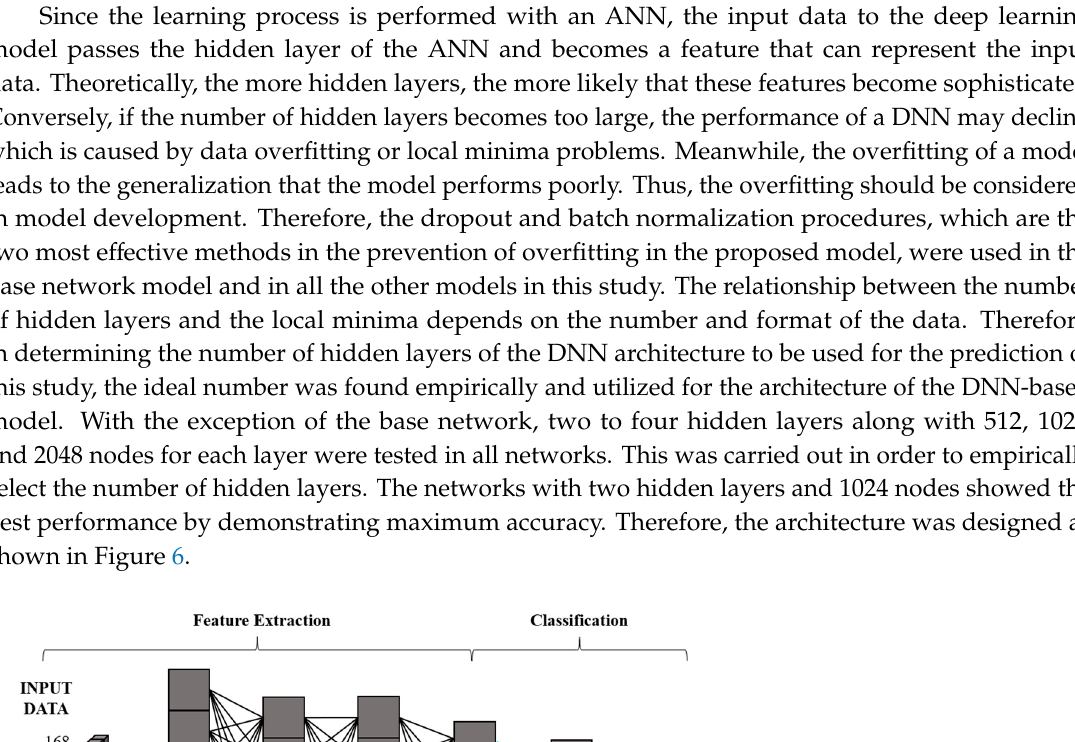
Figure 5. Base network architecture .